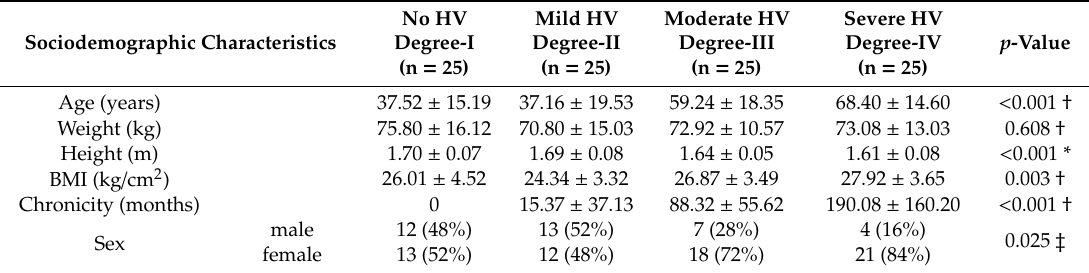
Table 1. Demographic data among di ff erent HV deformity